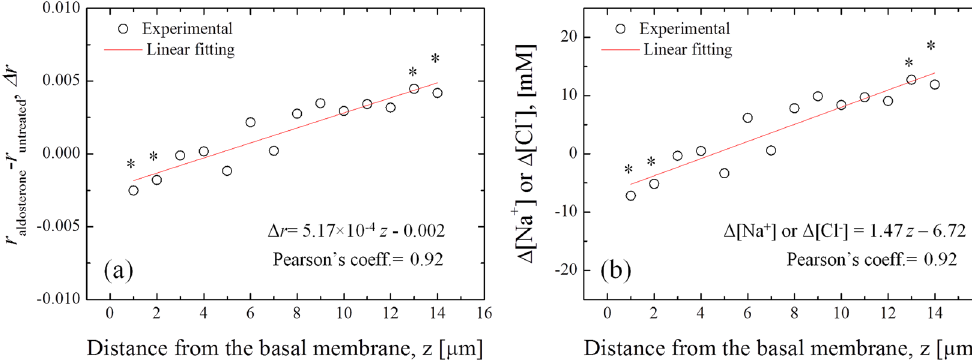
Figure 7. ( a ) Difference of the ratio r between treated and untreated cells as calculated in the cytosol of A6 epithelial cells. ( b ) The data reported in ( a ) can be converted to variation of [Na + ] or [Cl − ] in the cytosol using the linear fitting equation reported in the inset of Fig. 3(a). At each z-axis coordinate, the statistically meaningful variations of r and [Na] (or [Cl − ]) are marked by * (unpaired t-test, 95% confidence, p <